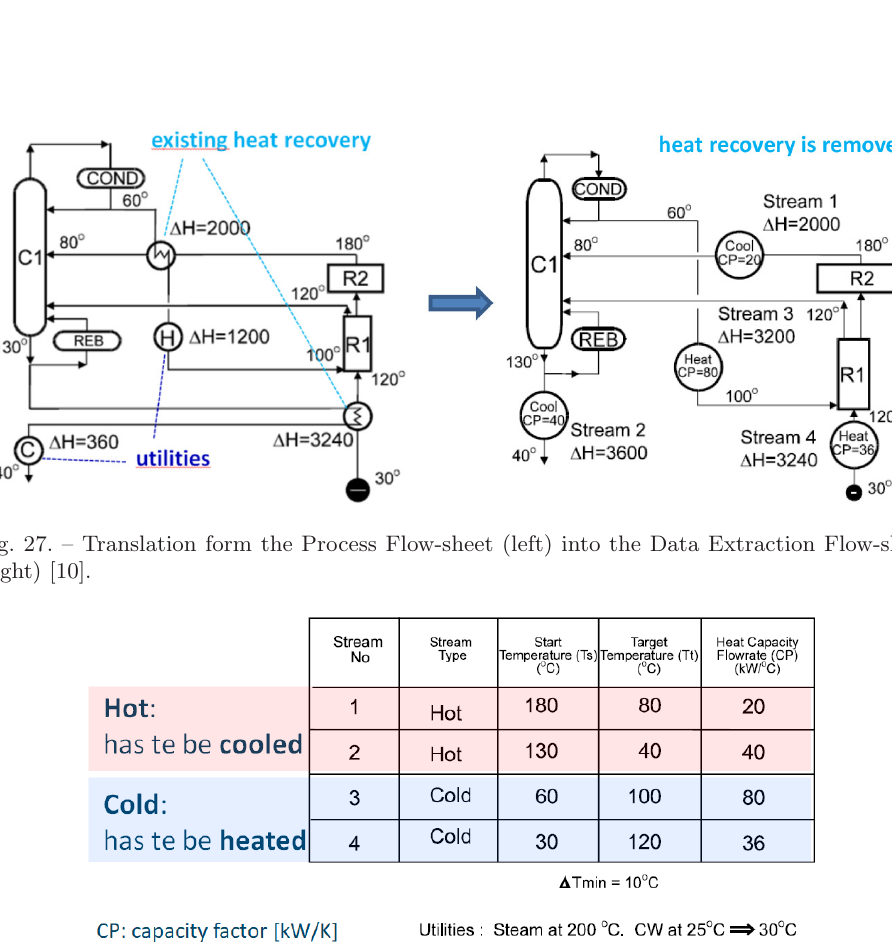
Fig. 28. – Data Extraction Table